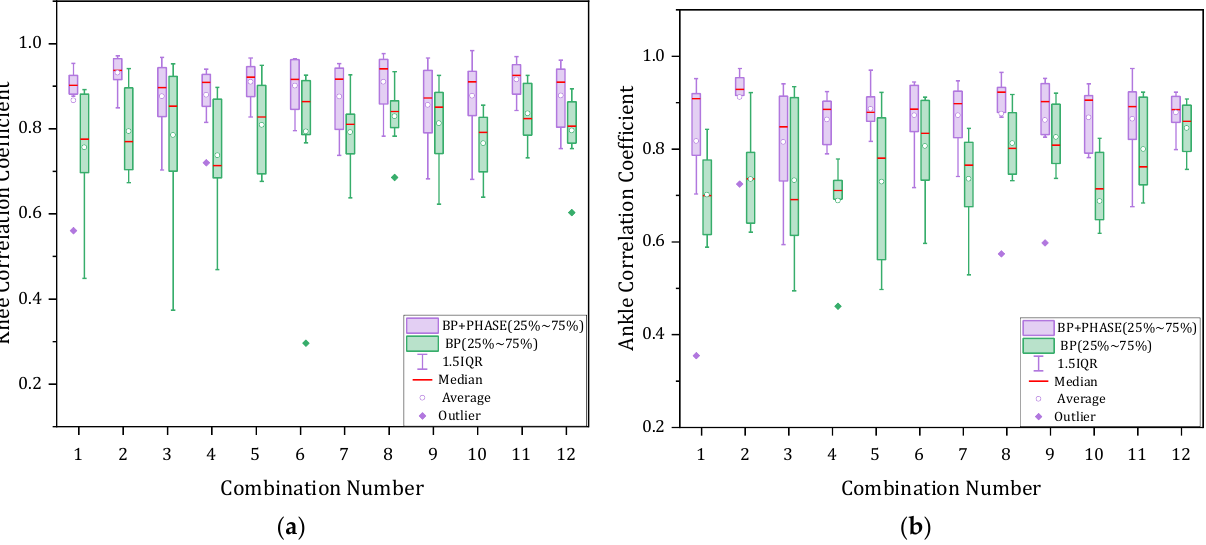
Figure 7. The distribution of knee ( a ) correlation coefficients using the three muscle ankle joints for 12 subjects. The distribution of ankle ( b ) correlation coefficients using the three muscle ankle joints for 12 subjects. The muscle combinations represented by the numbers can be found in Table 3. Small squares represent small data variance and aggregated data distribution. Large squares represent large data variance and scattered data